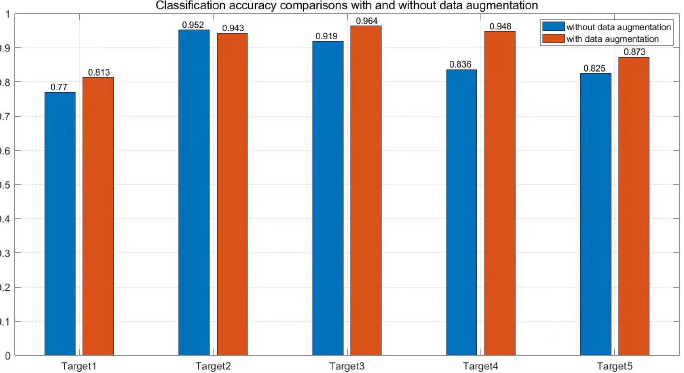
Figure 11. Classification accuracy comparisons with and without data